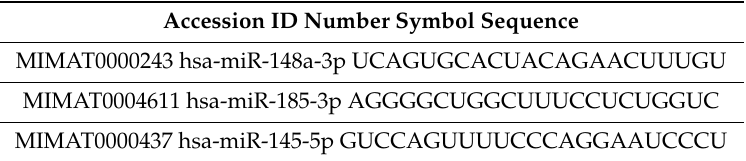
Table 3. miRNA collection: accession number, symbol, sequence, and identification number used in this study of miRNA